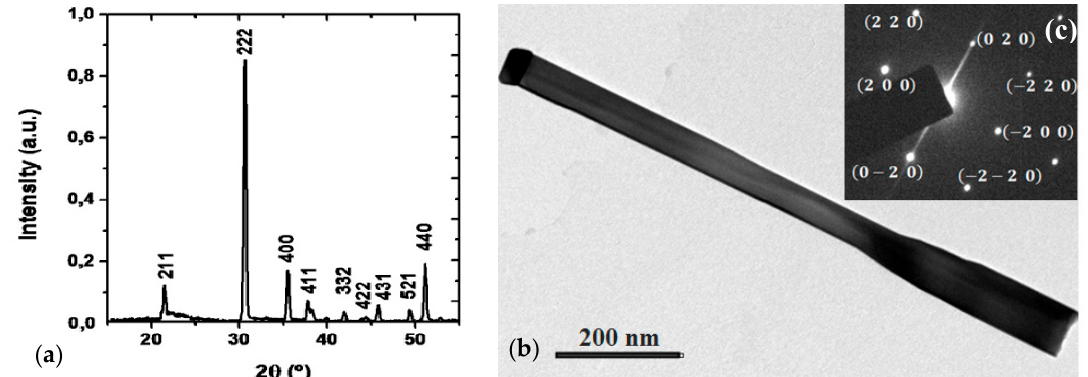
Figure 2. ( a ) Measured XRD diagram of (Ga,In) 2 O 3 ; TEM images of the ( b ) NW of the samples and the ( c ) corresponding electron diffraction image.